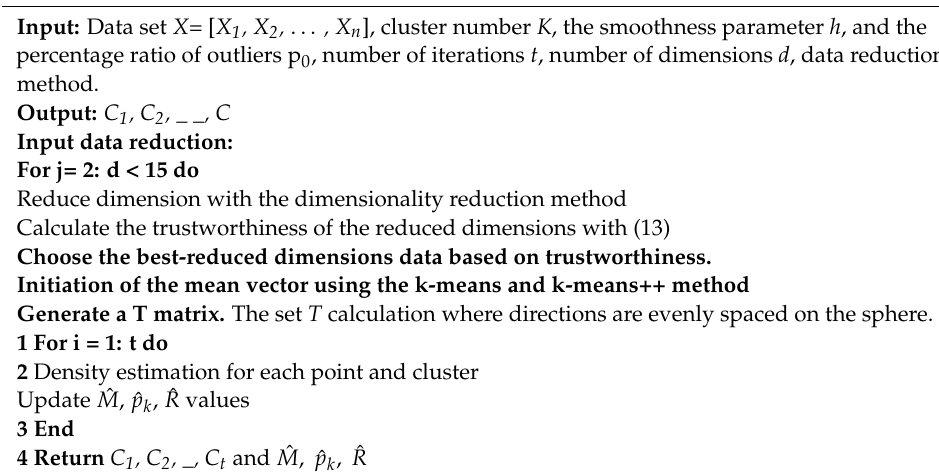
Algorithm 2: RCBMIDE clustering